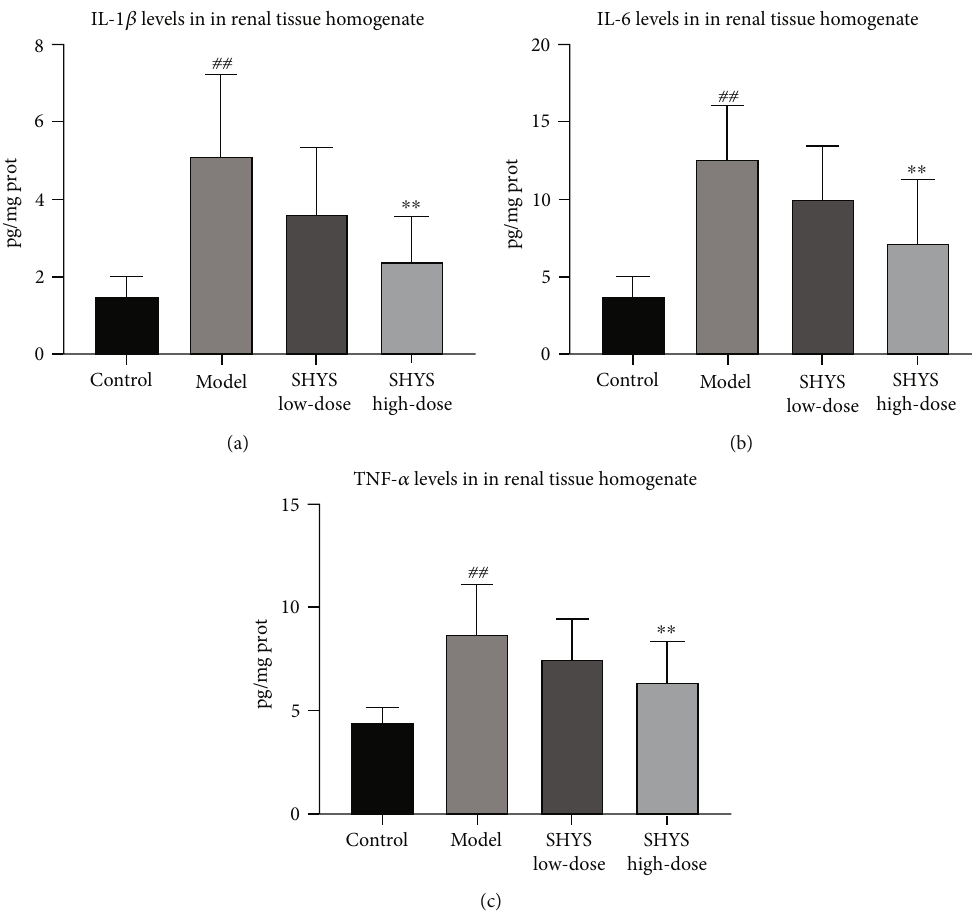
Figure 2: Anti-in fl ammatory e ff ects of SHYS on DKD model rats. The anti-in fl ammatory e ff ects of SHYS on DKD were evaluated by investigating the levels of proin fl ammatory cytokines (IL-1 β , IL-6, and TNF- α ) in renal tissue homogenates using ELISA. (a) – (c) SHYS treatment decreased the levels of IL-1 β (a), IL-6 (b), and TNF- α (c) in renal tissue homogenates in DKD model rats. Table 3: Activities of SOD and GSH-Px and level of MDA in renal tissue homogenates after SHYS